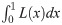
Illustration of the nested sampling approximation with a uniform prior on [0, 1].A: The integral over the parameter space ∫Ω
l(θ)dθ. B: The transformed integral ∫01L(x)dx over the prior volume x.